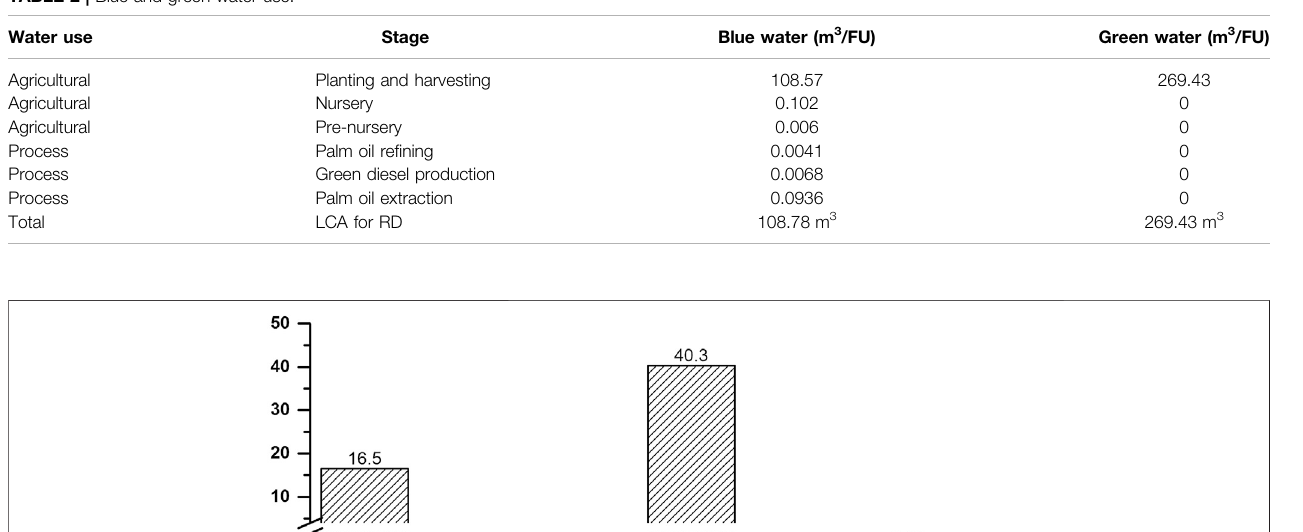
TABLE 2 | Blue and green water use.